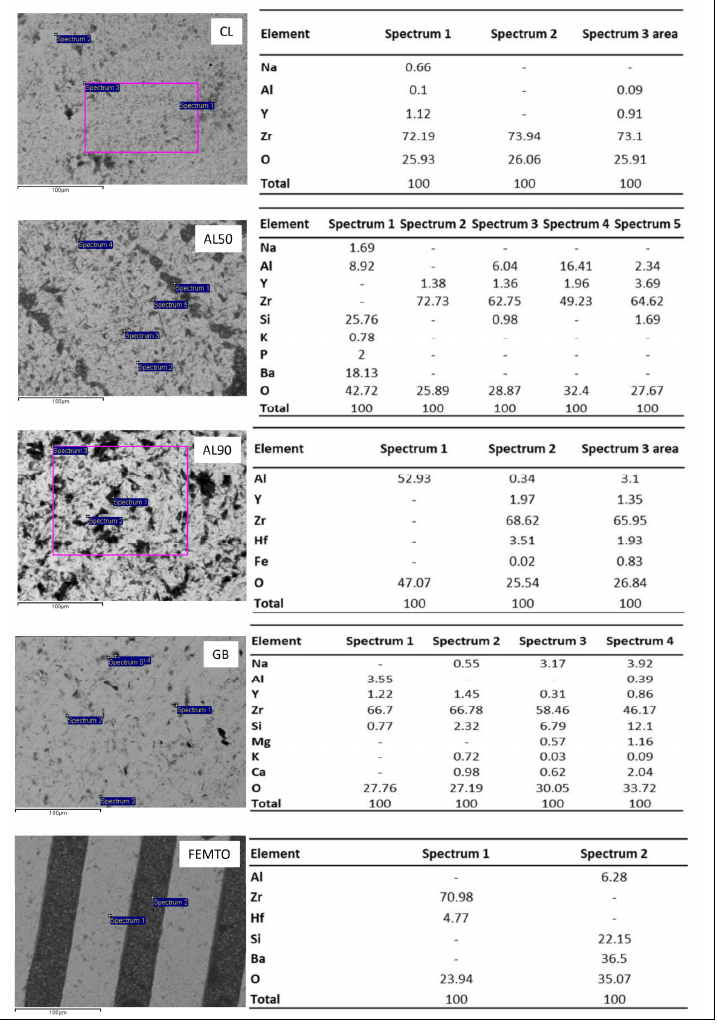
Figure 3. Left: SEM Backscattered microphotographs. Right: EDS compositional analysis from the respective microphotographs.